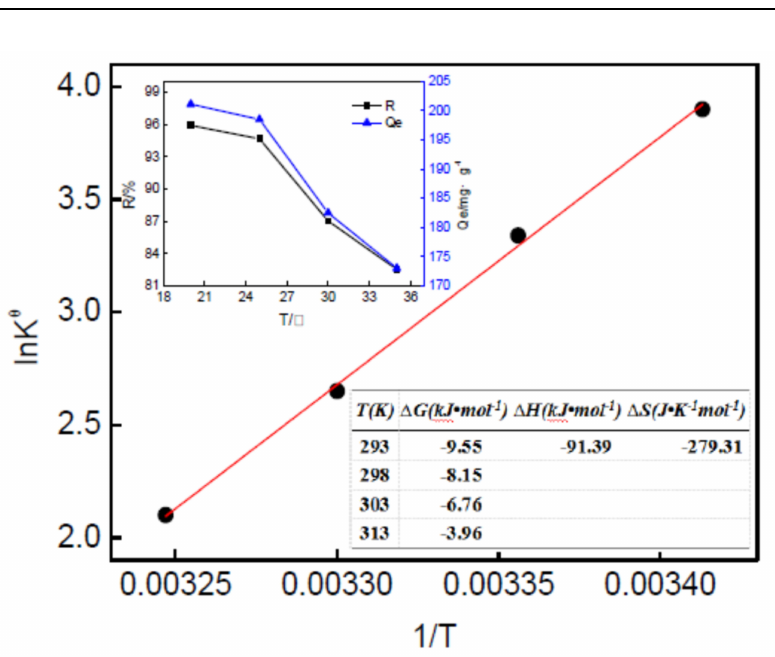
Figure 3. Van’t Hoff fit curve (inset at the upper left corner: dependence of adsorption on temperature, at the lower right corner: values of adsorption thermodynamic functions). Reproduced under creative commons agreement from